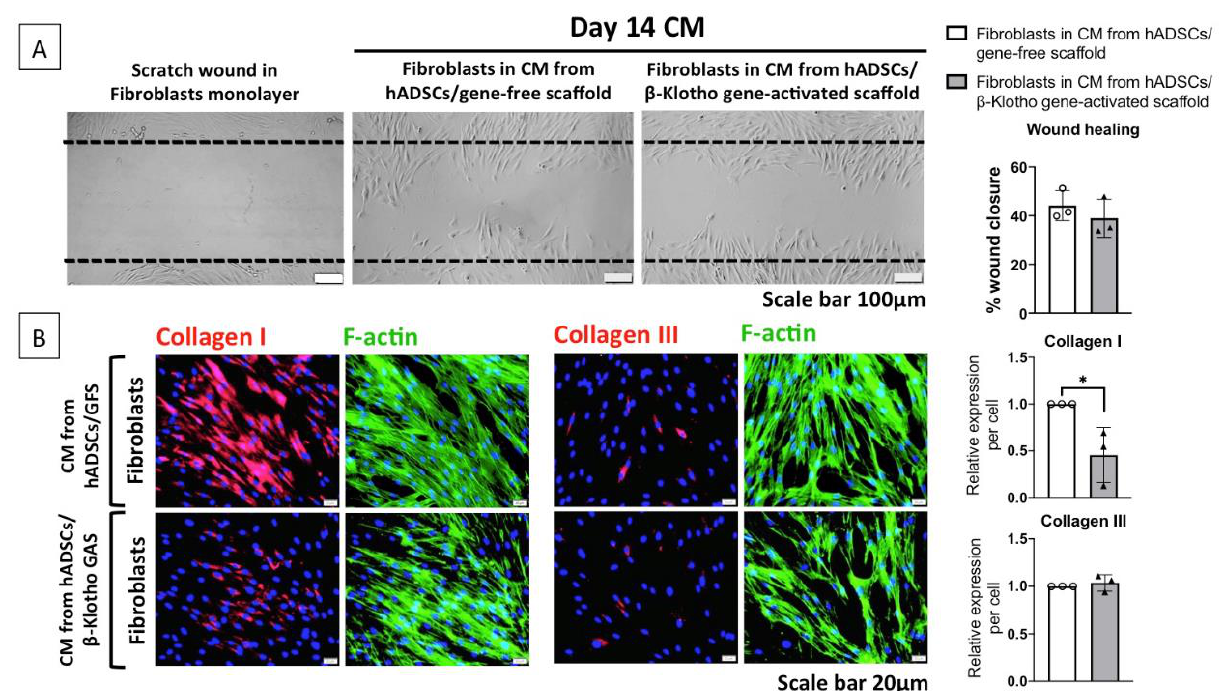
Figure 3. Paracrine influence on dermal healing and maturation. ( A ) Aged day 14 CM from both the groups exerted similar levels of wound closure activity in human adult dermal fibroblasts by approximately 40% in 12 h. ( B ) CM from the gene-activated scaffold significantly reduced the expression of pro-fibrotic collagen I in the fibroblasts. * indicates p < 0.05. Data represents mean ± standard deviation ( n = 3). In Figure 3B, GAS and GFS stand for gene-activated scaffold and gene-free scaffold respectively.